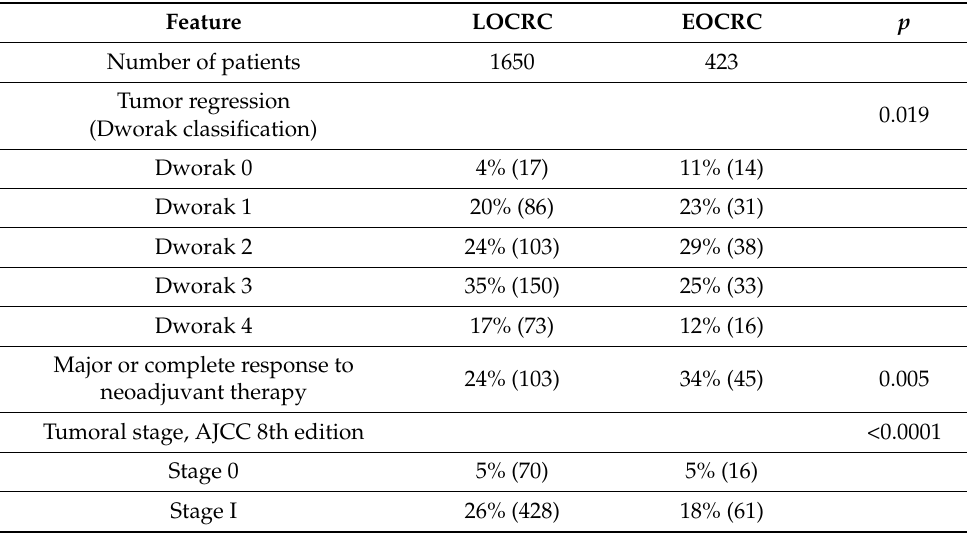
Table 3. Pathological and molecular features, median [IQR], and %